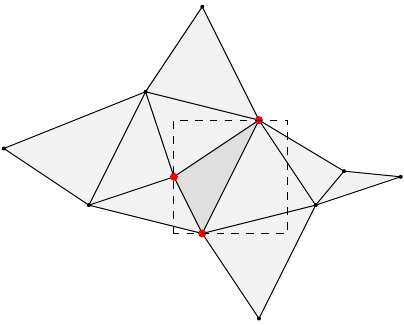
Figure 2: An L ∞ -Delaunay triangulation with one of the maximal squares